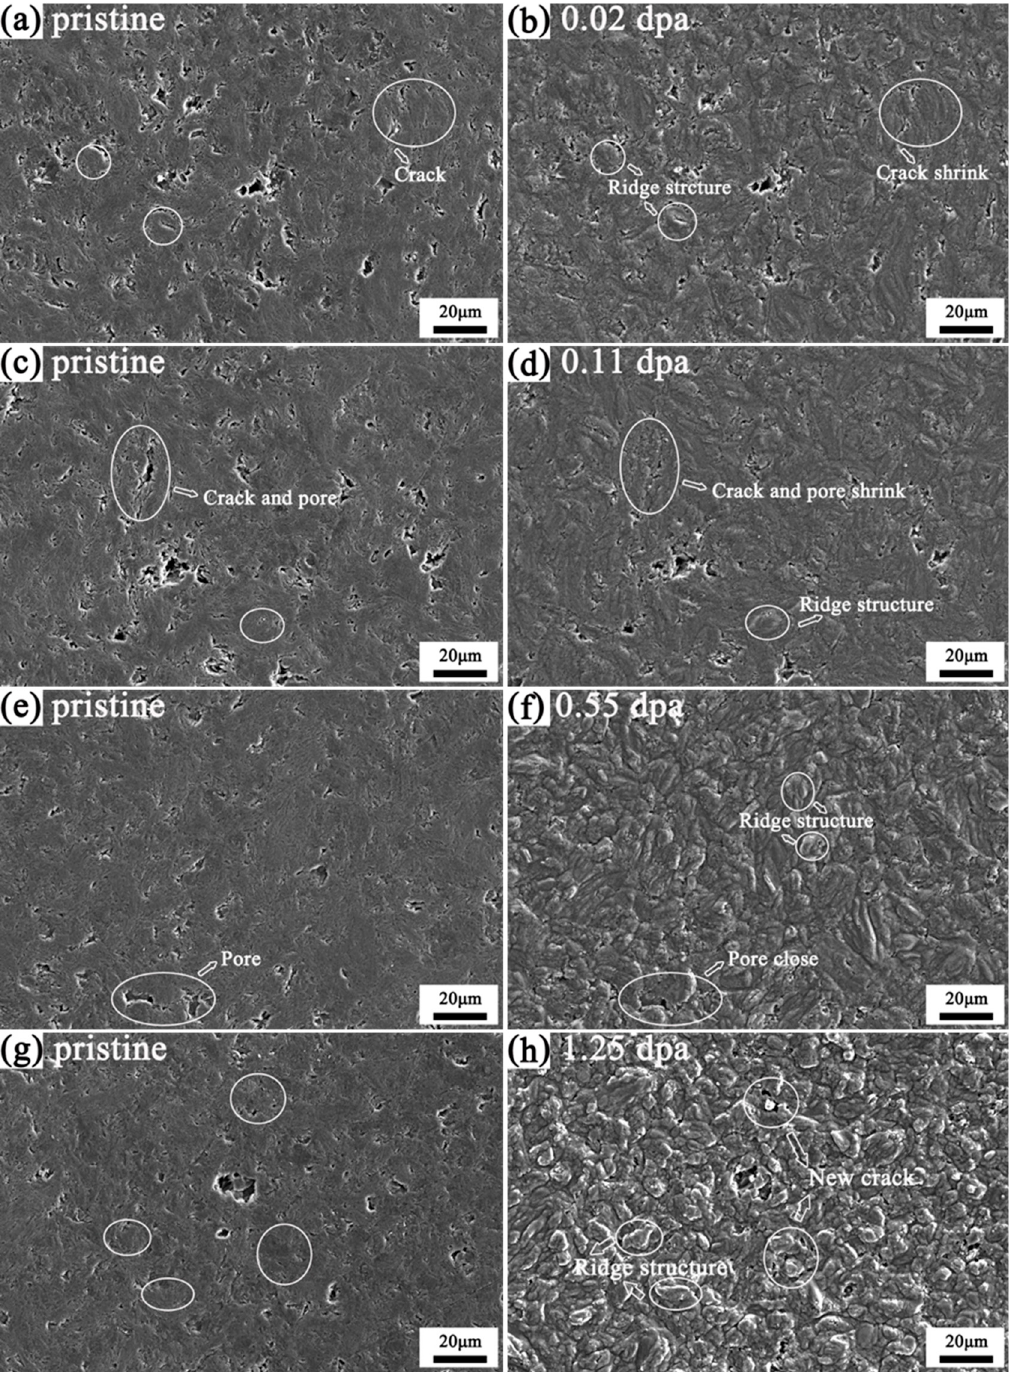
Figure 2. SEM images of 75N25C-G before ( a , c , e , g ) and after irradiation at a surface irradiation dose of 0.02 dpa ( b ), 0.11 dpa ( d ), 0.55 dpa ( f ) and 1.25 dpa ( h ). Magnified SEM images of NG and 75NG25C-G before and after irradiation at a surface damage dose of 0.02 dpa and 1.25 dpa are shown in Figure 3. The magnified SEM images show that after low-dose irradiation, the pores between graphite shrink due to the expansion of graphite crystallites, and the surface becomes compact and smooth. After irradiation at 1.25 dpa, the surface morphology of NG and 75NG25C-G are quite different.